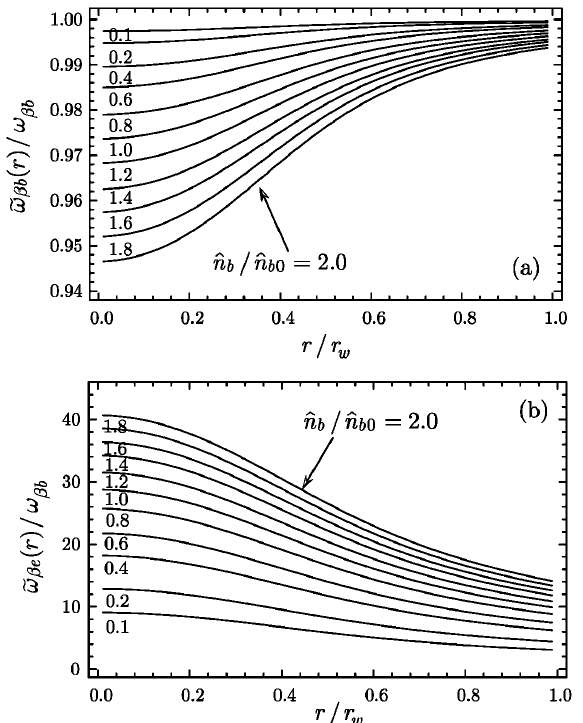
(cid:1) ~ !! (cid:3) for the j (cid:13)j